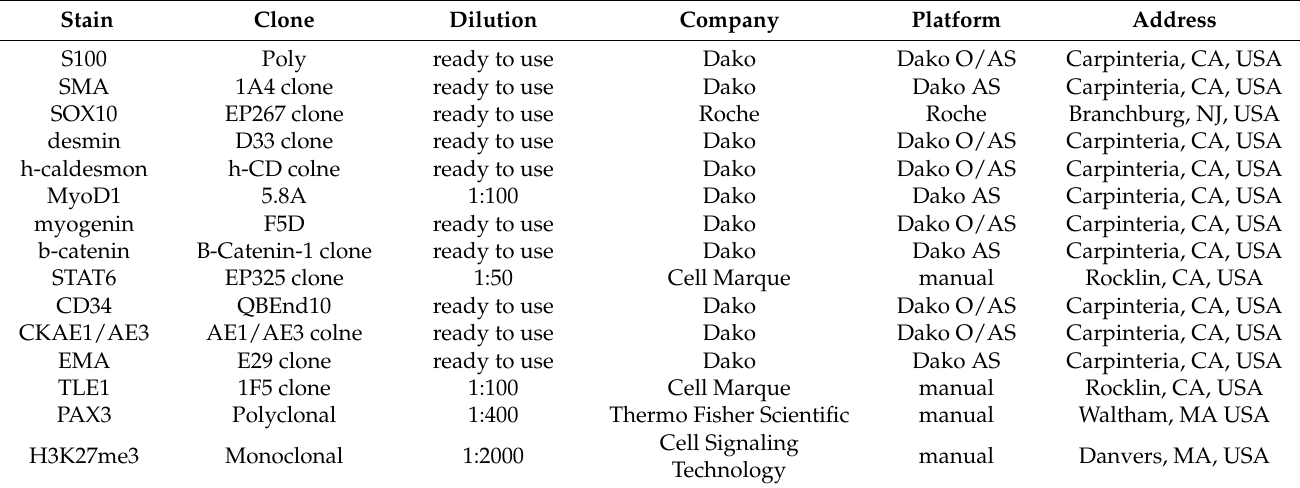
Table 1. Immunohistochemical staining